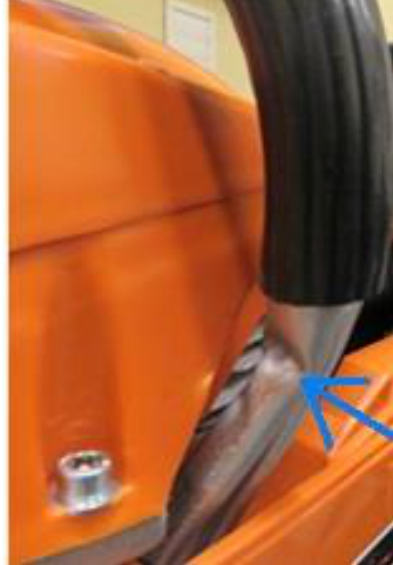
Figure 7. Bent front handle of chainsaw after strength tests.